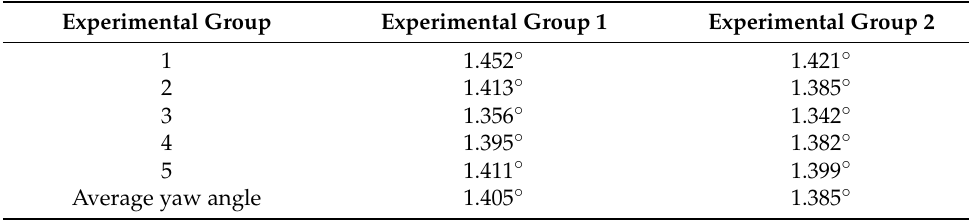
Table 3. Yaw angle